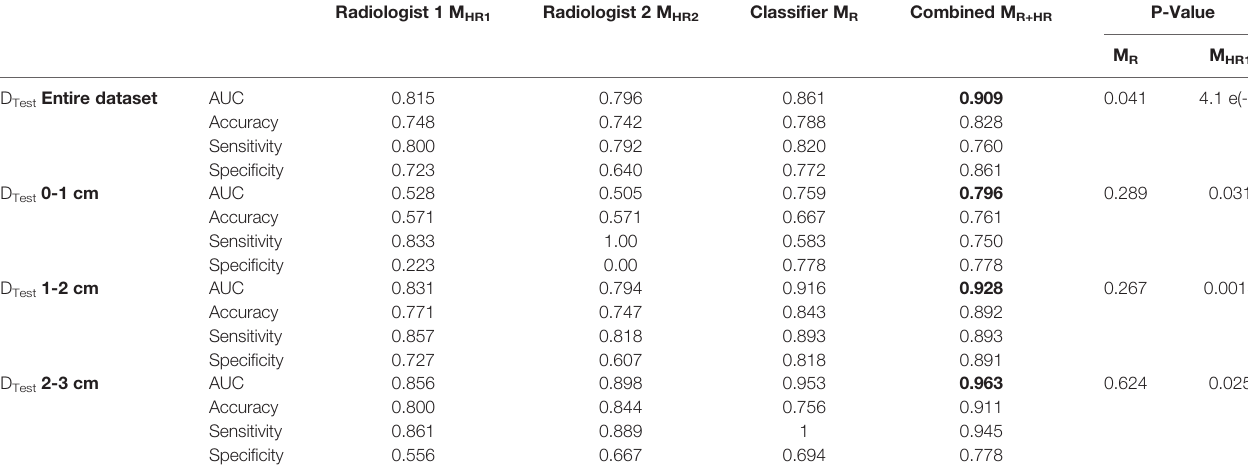
TABLE 3 | AUC comparison for logistic regression model trained with radiologists ’ interpretations, M HR., radiomic features, M R, and combined radiomic and area-based models, M R+HR on the test set. P-value is calculated to observe the added bene fi t of M HR in the radiomics model, M R